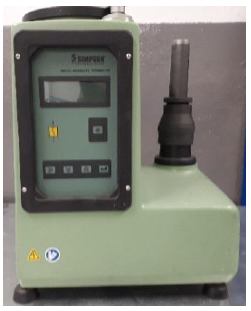
Figure 2. Simpson digital permmeter.